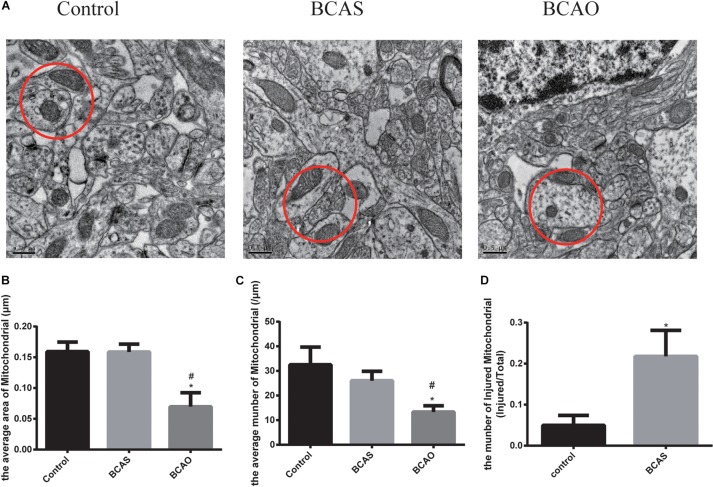
Electron microscopy data for the hippocampal CA1 area in the three experimental groups. (A) Red circles indicate mitochondria. The average area (B) and total number of mitochondria (C) in the hippocampal CA1 area 30 days after surgery are depicted. (D) The number of injured mitochondria (mitochondrion with crista broken) in the control and BCAS groups. Data are expressed as the mean ± SD (n = 6/group). *P < 0.05 compared with the control group, #P < 0.05 compared with the BCAS group; BCAS, bilateral common carotid artery stenosis; BCAO, bilateral common carotid artery occlusion; SD, standard deviation.